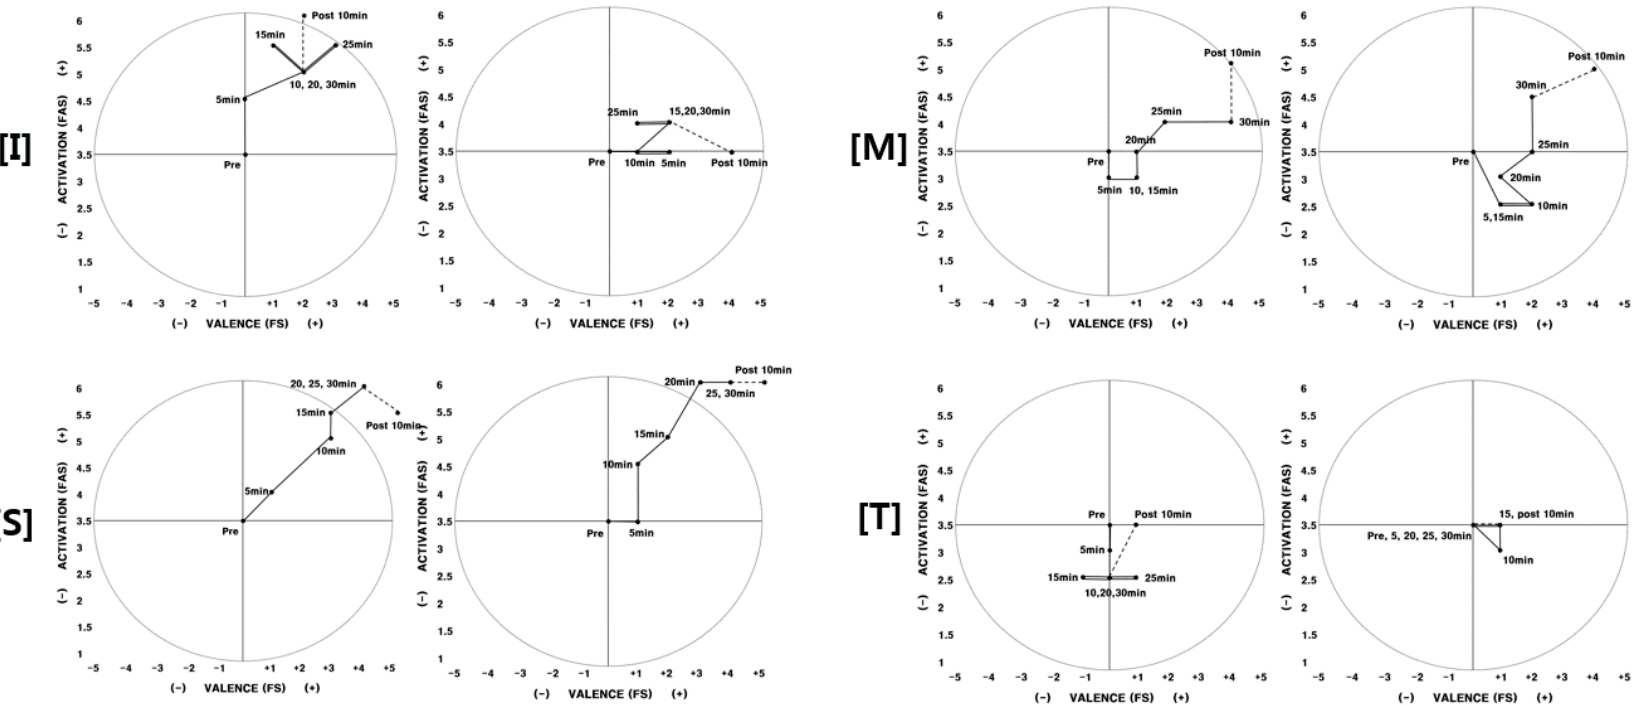
Figure 4. 2D circumplex model (participants I, M, S, T) Note. Left: 1st experiment/Right: 2nd experiment. FAS: felt arousal scale; FS: feeling scale.